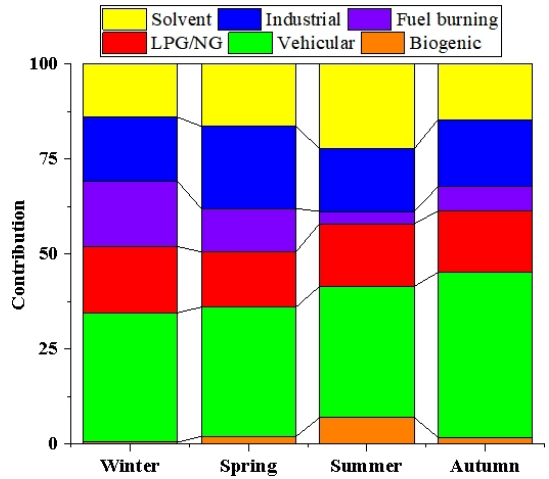
Figure 6. The contributions of each VOC source during 2018– Figure 7. Seasonal variation in source contributions to VOC con-